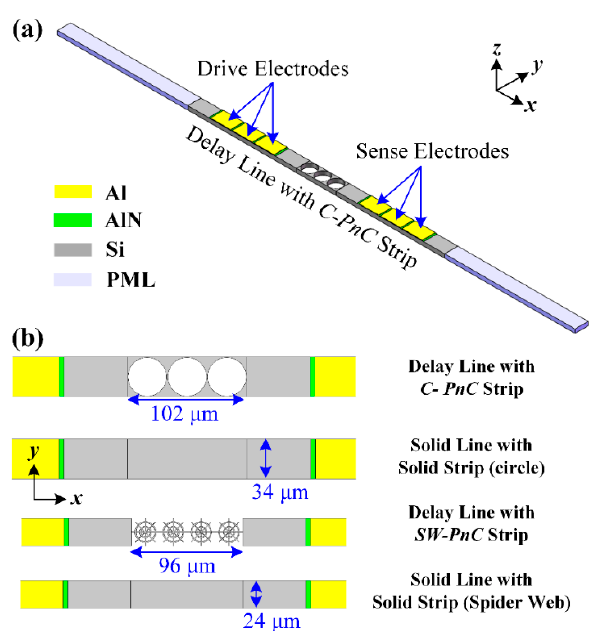
Figure 2. ( a ) Schematic set-up for the computation of the transmission property of the acoustic delay line with a finite C-PnC strip. Furthermore, ( b ) the delay line and solid line with the PnC strip, and with the solid silicon strip as the transmission medium between interdigital transducers (IDTs) were performed, verifying the existence of acoustic bandgaps formed by the associated PnC. In this research, periodic boundary conditions were applied to surfaces along the y-direction of the delay line and solid line to form the 2D PnC slab and reference solid slab, while improving the calculation efficiency.